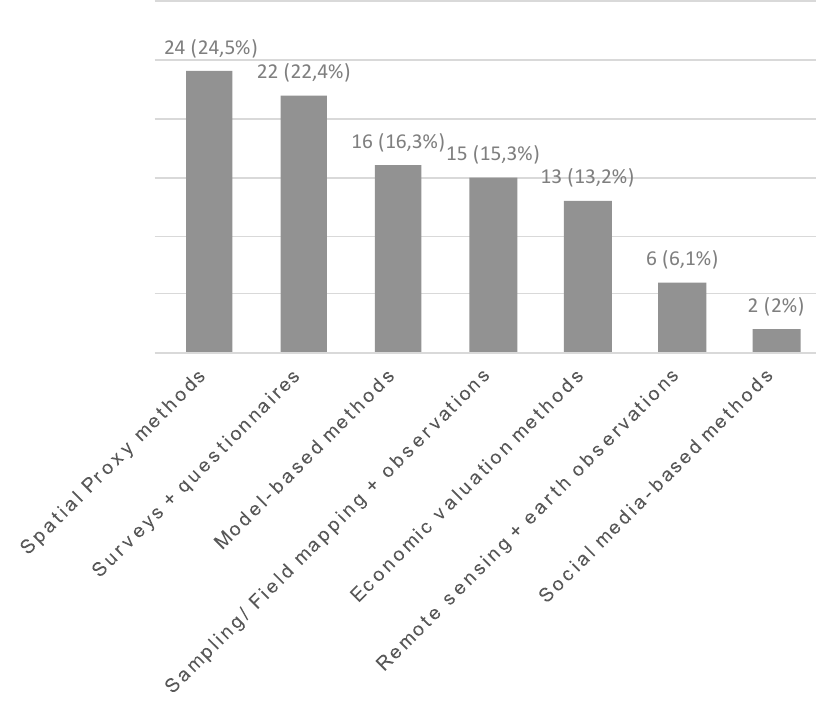
Figure 4. Numbers (and % of total share) of methods used in the reviewed articles.